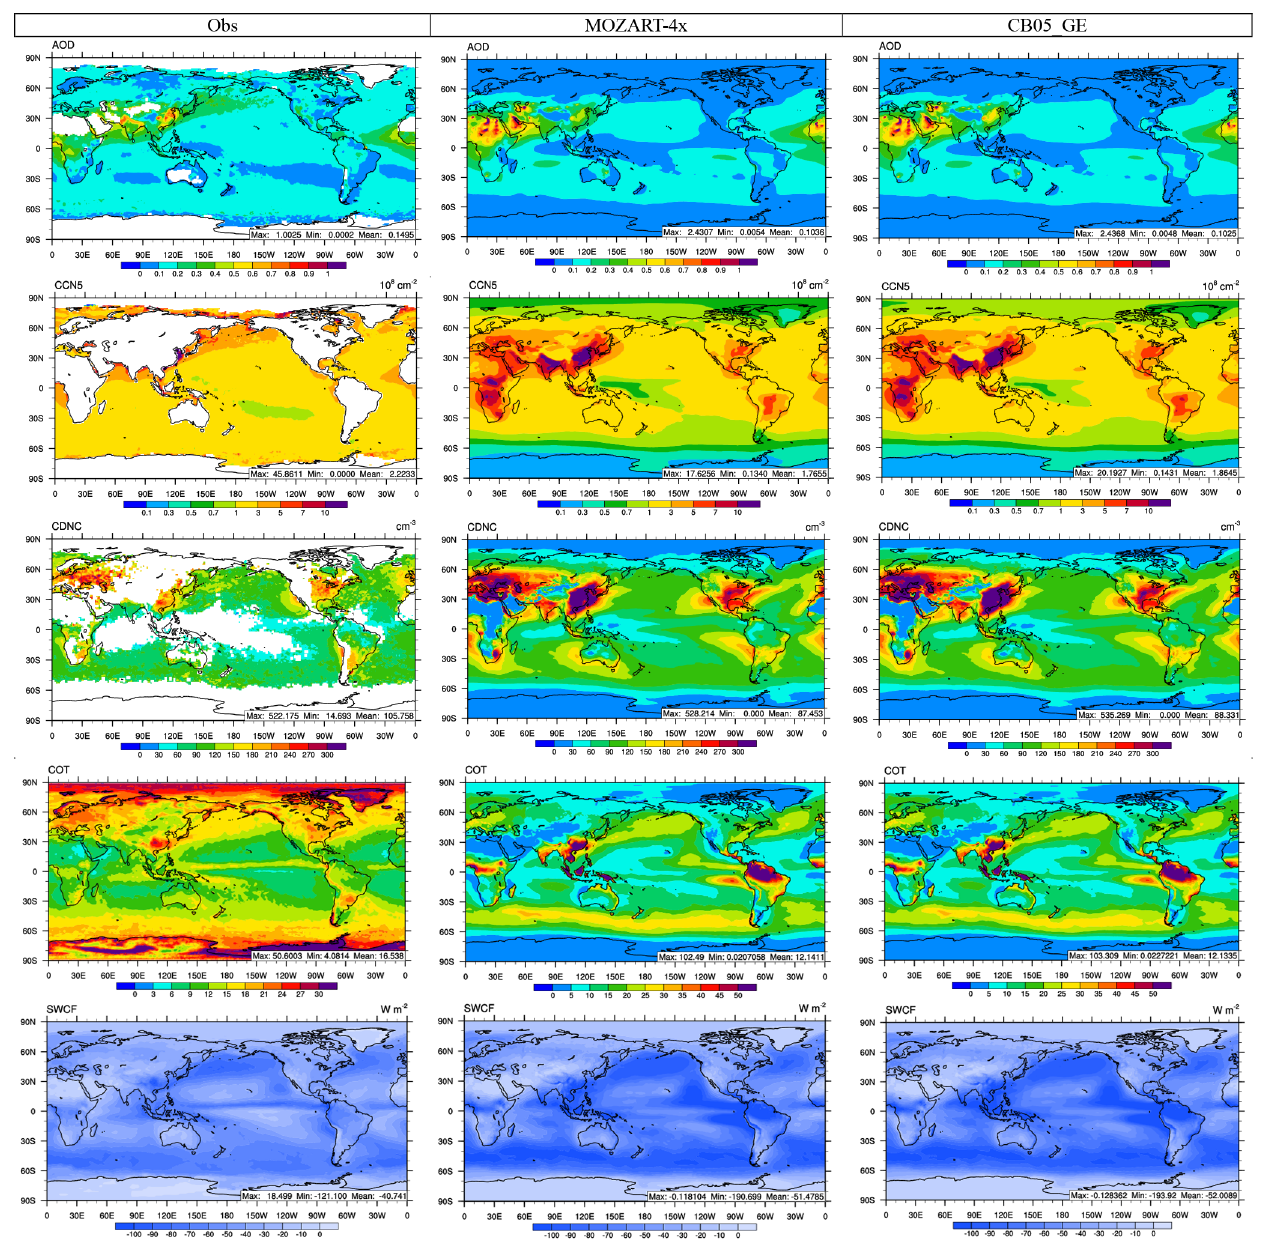
Figure 7. Comparison of satellite observations with predictions of AOD, CCN5, CDNC, COT, and SWCF by MOZART-4x and